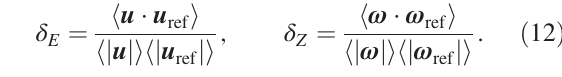
FIG. 2. Top: Visualizations of (left) reference fields u Eulerian nudging. The parameters are α t η ¼ 6 . 5 , τ =t η ¼ 1 . 5 , ϕ ¼ 0 . 05 . Bottom: Same as above but for Lagrangian nudging. The parameters are α t η ¼ 6 . 5 , τ =t η ¼ 1 . 5 , ϕ ¼ 0 . 03 . All flows are visualized at the final time of the simulations; see Sec. II B for more